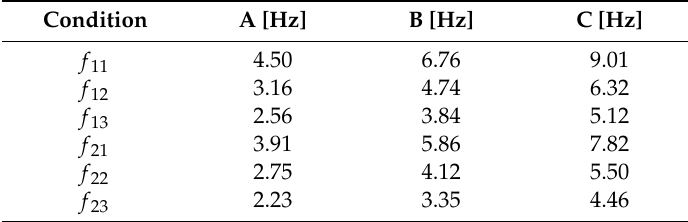
Table 4. The results for frequency obtained from Equation (4).